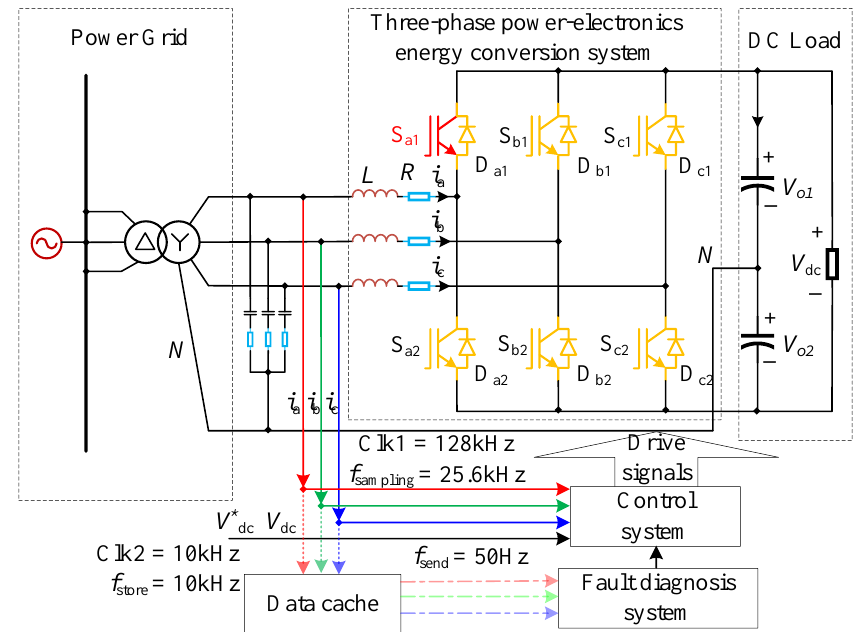
Figure 14. Fault diagnosis schematic for power electronic energy conversion